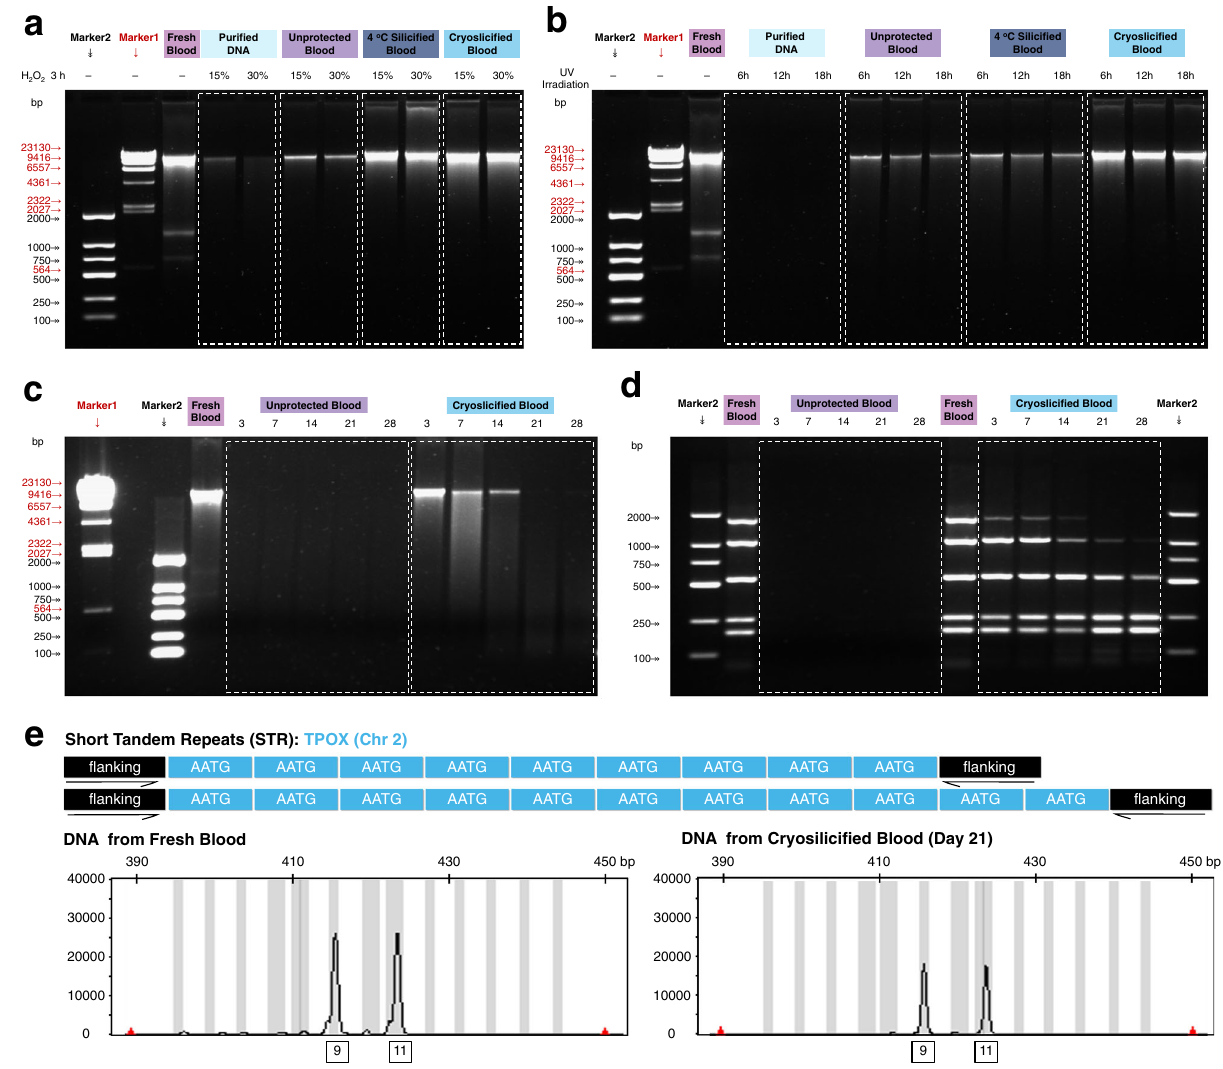
Fig.4|Robustandlong-termDNApreservation.a , b GelelectrophoresisofDNA extracted from fresh blood sample and puri fi ed DNA, unprotected blood, 4°C silici fi ed blood, and cryosilici fi ed blood samples after a H 2 O 2 and b UV treatment. Arepresentativeimageofthreebiologicalreplicatesisshown. c Gelelectrophoresis of DNA extracted from a fresh blood sample, and unprotected blood and cryosi- lici fi ed blood samples aging at 70°C and 60% RH. A representative image of three